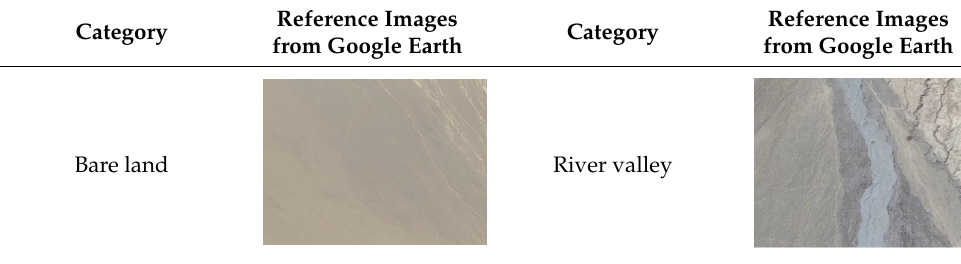
6 of 21 Table 1. Classification categories with examples of high-resolution imagery from Google Earth. Category